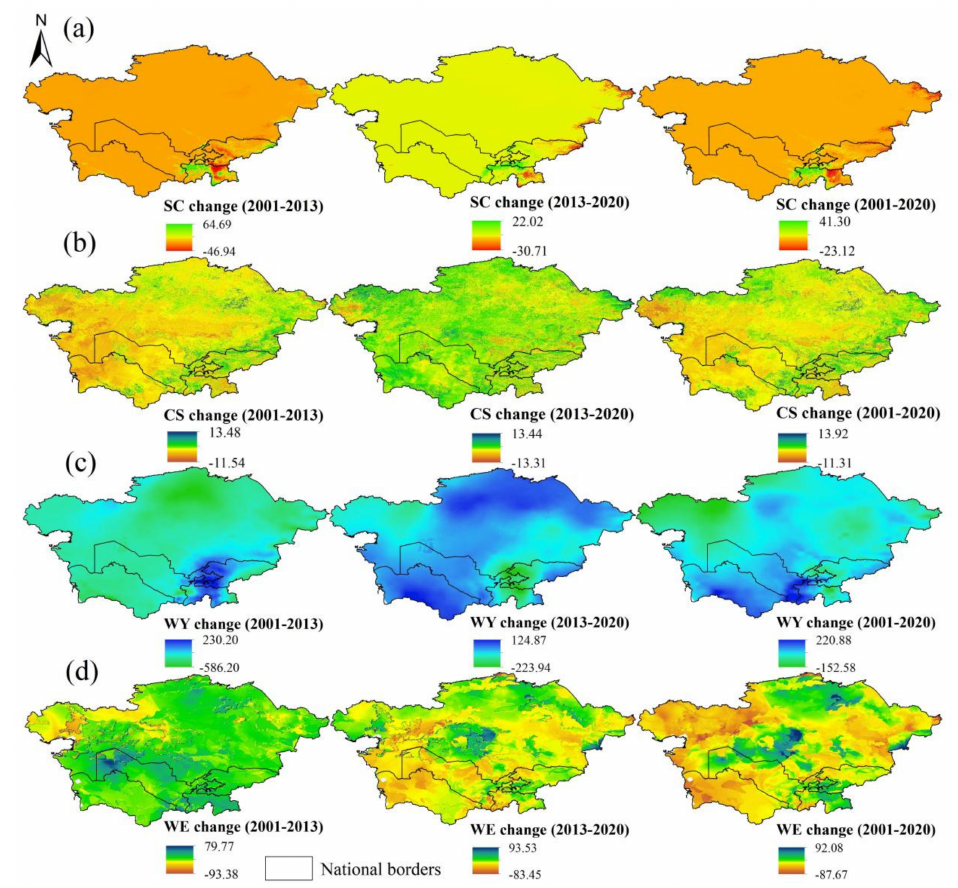
Figure 7. Spatial change in the ESs before BRI (2001–2013), after BRI (2013–2020) and 2001–2020. ( a ) SC change; ( b ) CS change; ( c ) WY change; ( d ) WE change. (SC, CS, WY, and WE refer to soil conservation, carbon sequestration, water yield, and wind erosion, respectively. The unit of SC and CS is t · hm − 2 , of WE is kg · m − 2 , and of WY is